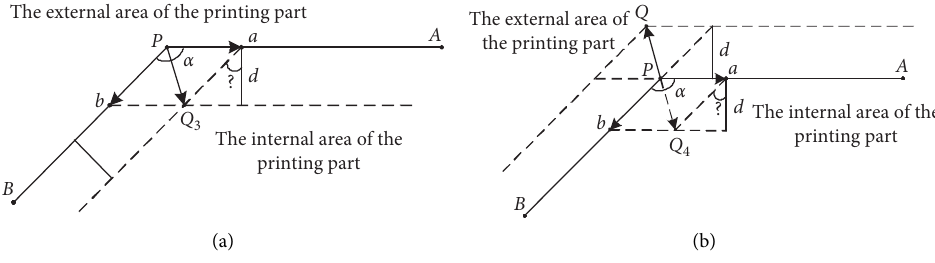
Figure 3: Contour point (P) in case 2. (a) The contour points are offset inward. (b) The contour points are offset